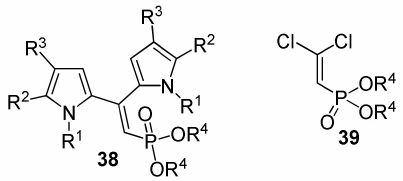
Figure 1. Side products of cross-coupling of pyrroles 35 with chloroethynylphosphonates 36